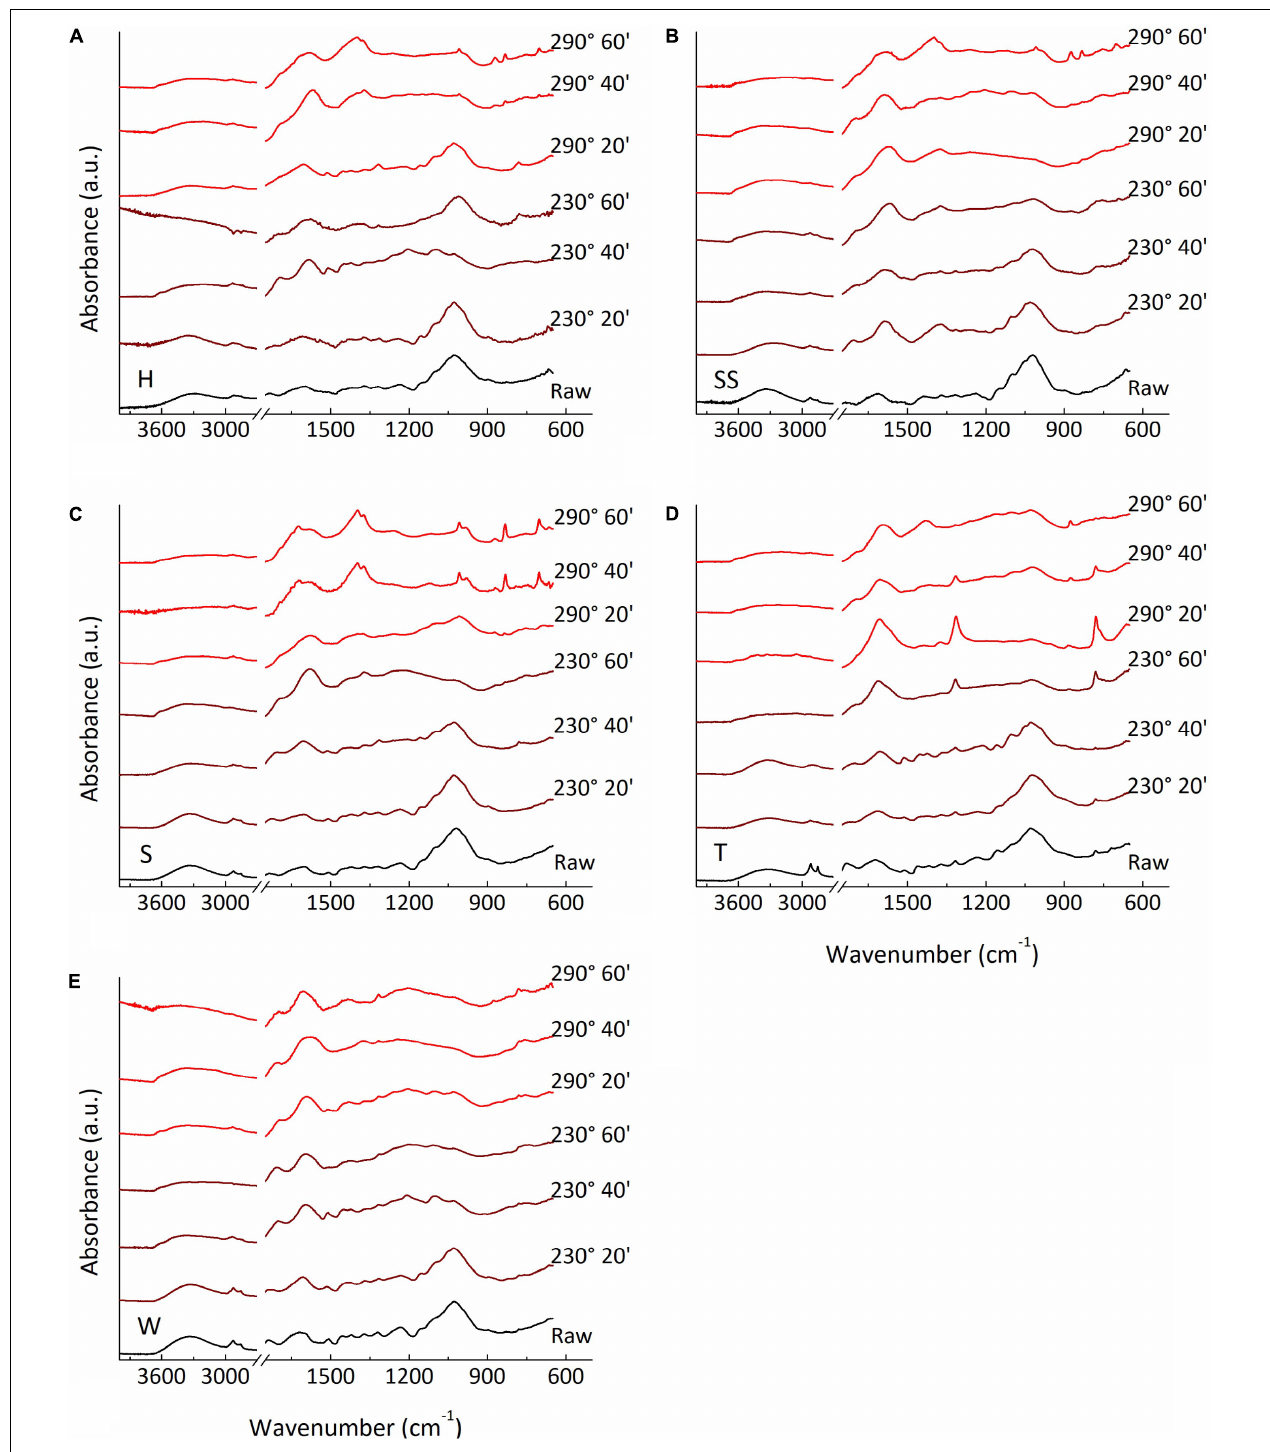
FIGURE 8 | FTIR spectra of (A) hard, (B) semi-soft, (C) soft almond shells, (D) almond twigs, and (E) walnut shells torrefied at different temperatures and residence times.